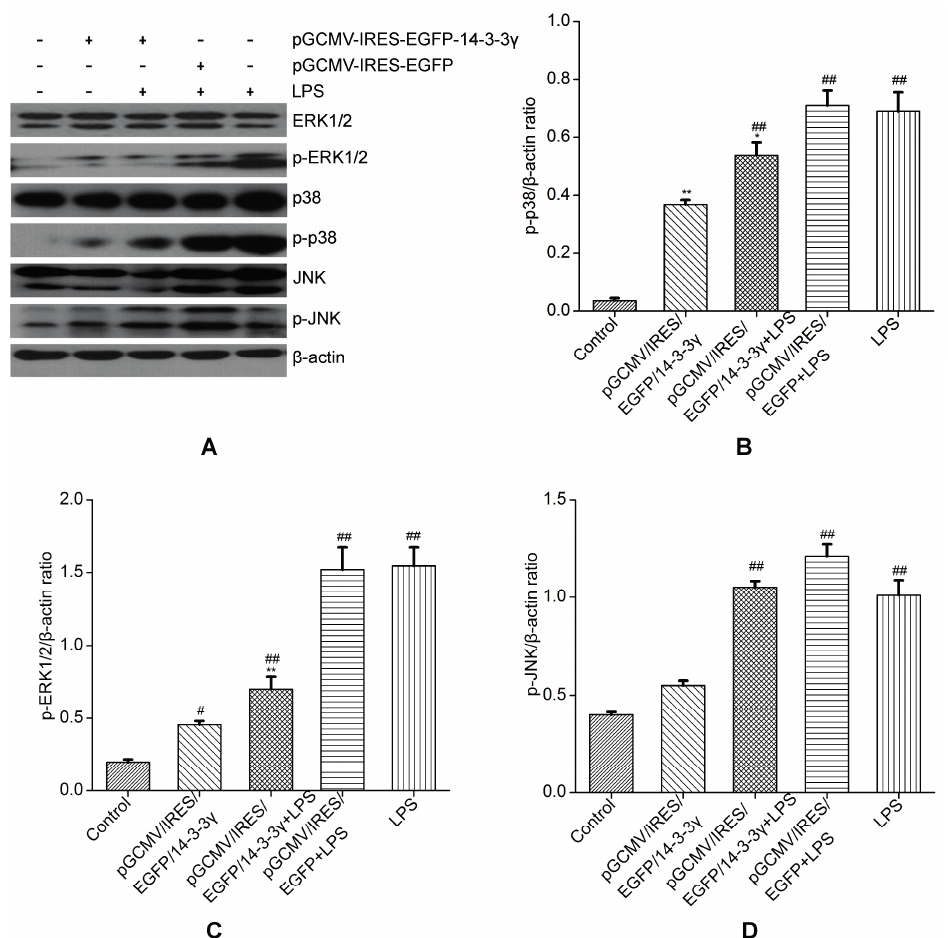
Figure 6. Effects of 14-3-3 γ overexpression on the mitogen-activated protein kinase (MAPK) signaling pathway in LPS-induced DCMECs. DCMECs were pre-transfected with pGCMV-IRES-EGFP-14-3-3 γ or pGCMV-IRES-EGFP. After 24 h, the cells were stimulated with LPS (1 μ g/mL) for 1 h. Cytosolic proteins were analyzed by western blot for extracellular signal regulated protein kinase 1/2 (ERK 1/2), p38 mitogen-activated protein kinase (p38 MAPK) and Junamino terminal kinase (JNK) phosphorylation. ( A ) Western blot detection of mentioned proteins; ( B ) Quantitation of p-p38; ( C ) Quantitation of p-ERK1/2; ( D ) Quantitation of p-JNK. β -Actin was used as a control. Bars indicate the mean ± SD ( n = 3). * p < 0.05 and ** p < 0.01 vs. LPS group; # p < 0.05 and ## p < 0.01 vs. control group. 2.7. 14-3-3 γ Overexpression Inhibited the Nuclear Factor- κ B (NF- κ B) Signaling